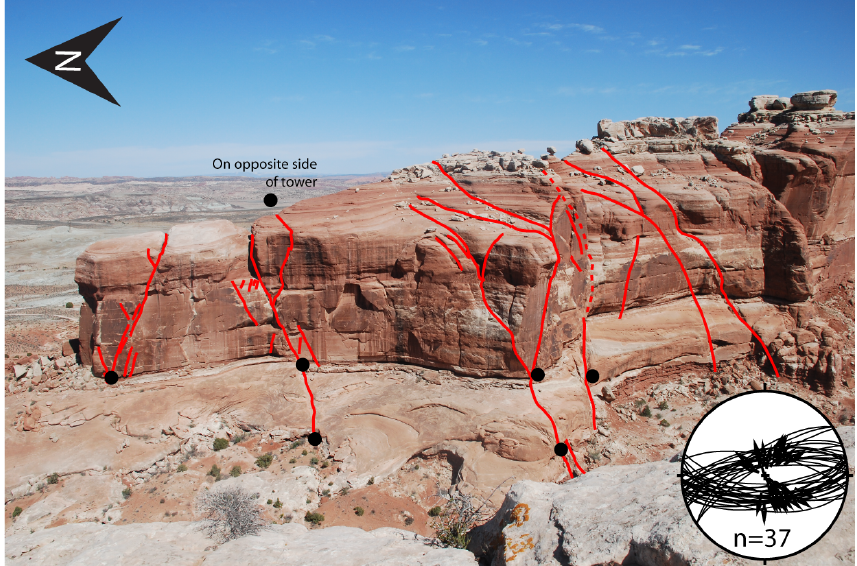
Figure 5. View of the western face of the northern termination of the Courthouse Rock (location I), with visible faults interpreted. The 27 measurements of striated slip planes are recorded at the stations indicated with the black dots. Width of view is about 400m. Stereonet shows the measured planes and slip directions. See Fig. 1b for location and direction info. CHJ is just off the image, to the